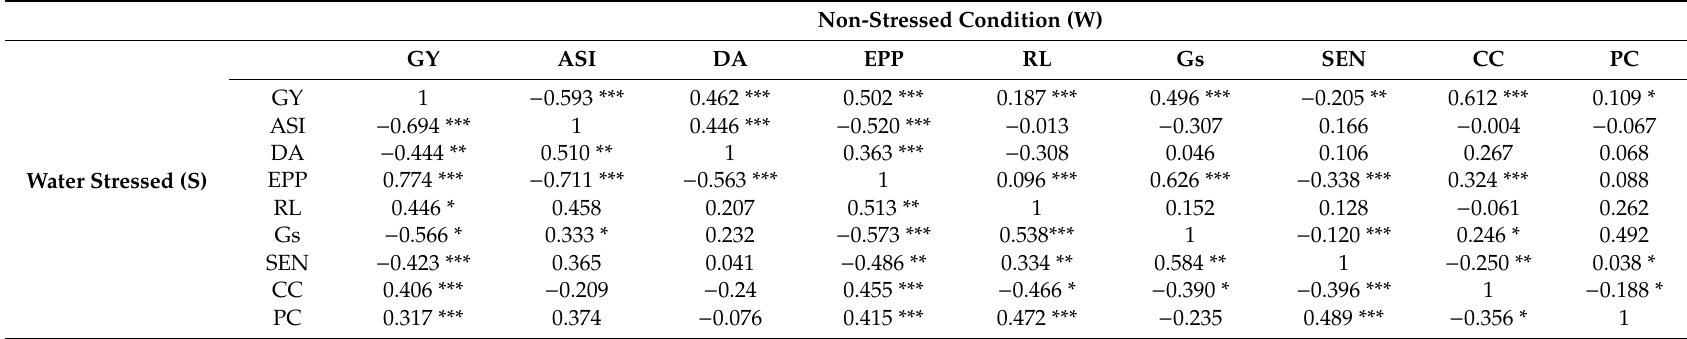
Table 4. Phenotypic correlation coe ffi cients describing association of traits under S (lower diagonal) and W (upper diagonal) conditions. Non-Stressed Condition